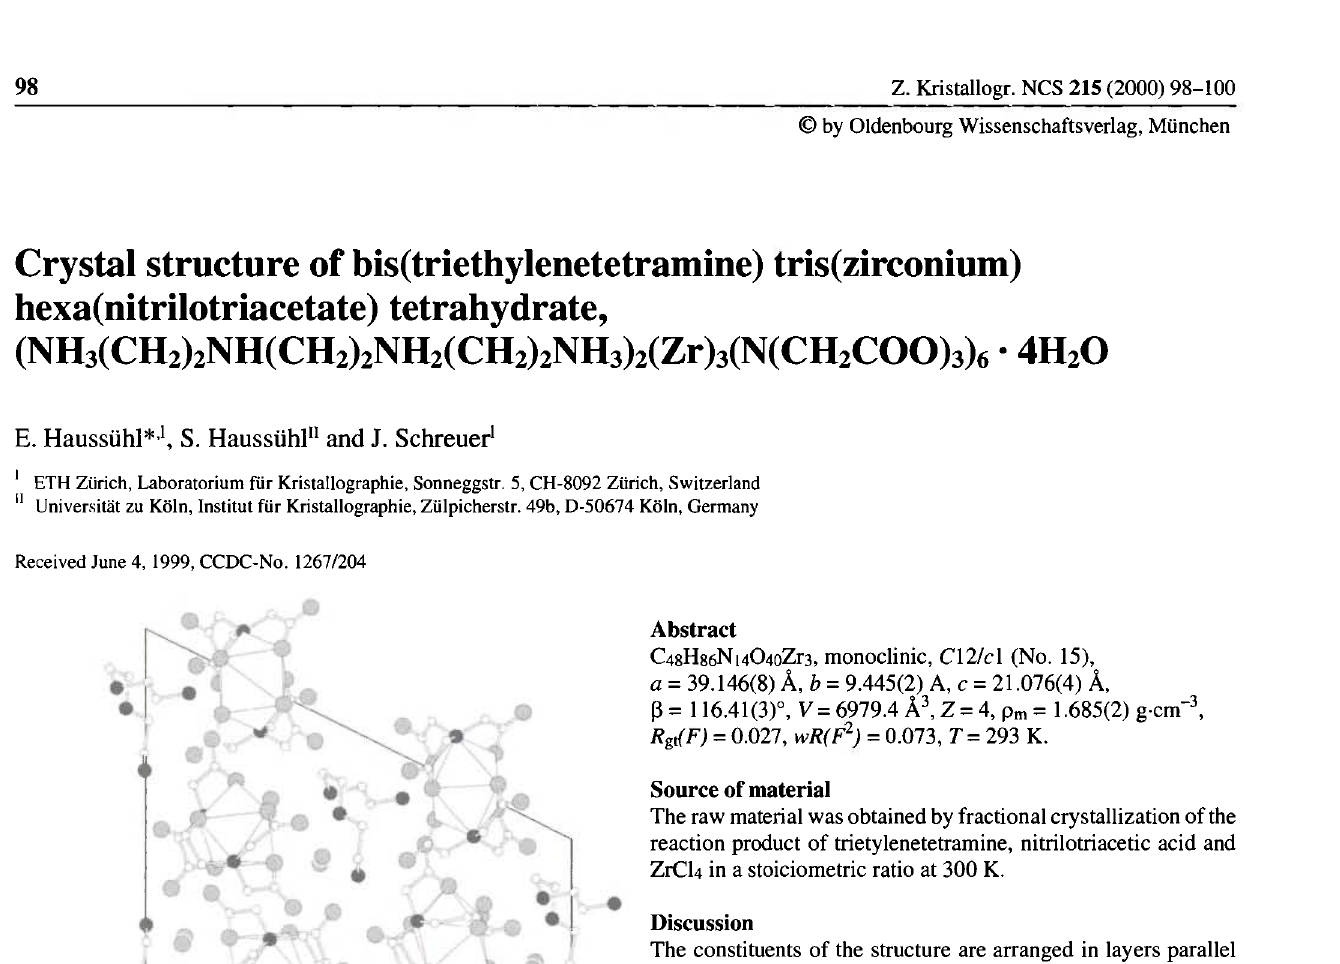
Table 1. Data collection and handling.